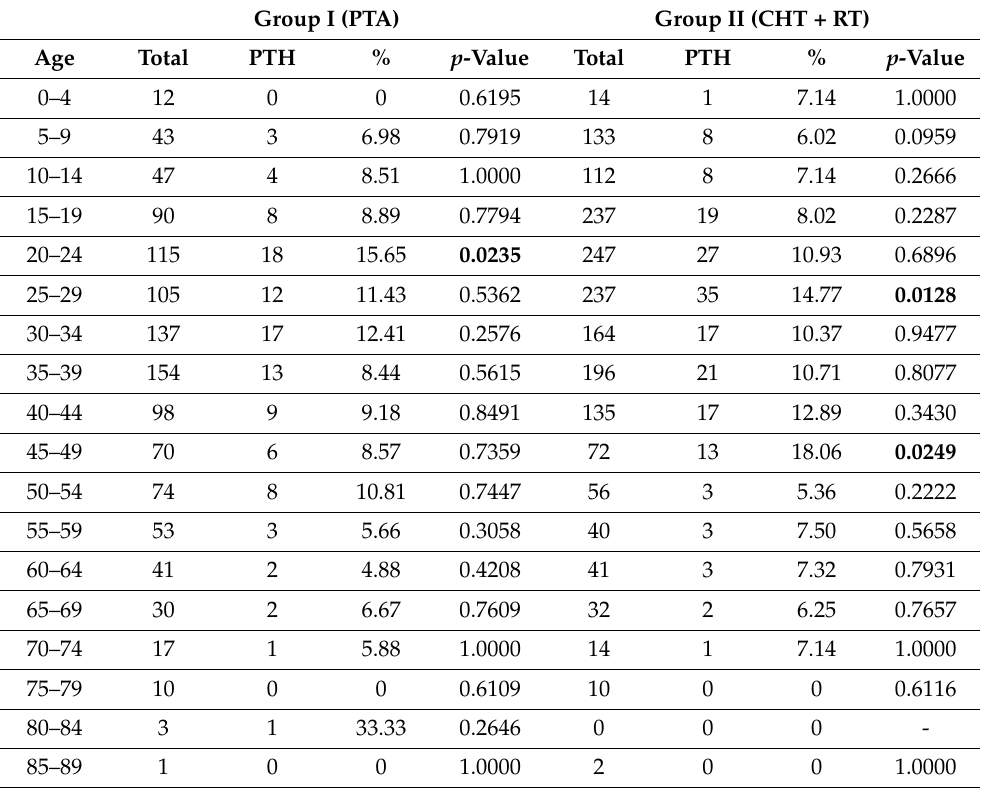
Table 7. Risk of bleeding in subgroups by age of